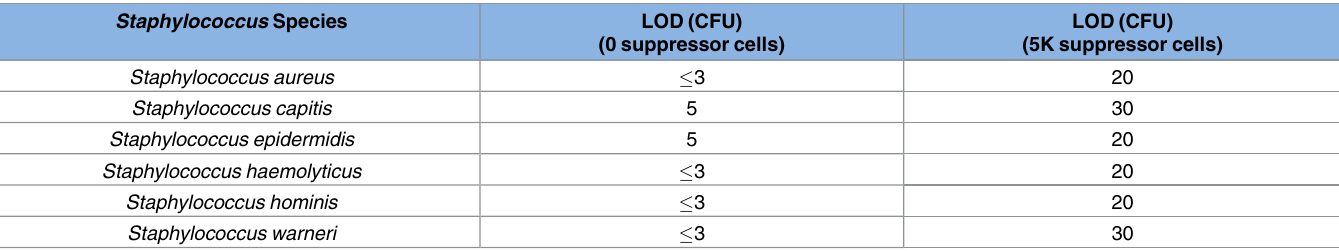
The limit of detection for the most clinically relevant Staphylococcus species was determined using primer pair tuf426F11/tuf527v1 for tuf gene amplification and Staphylococcus succinus as a competitive organism. Without any suppressor, the LOD for most of the Staphylococcus species examined was (cid:20) 3 CFU (middle